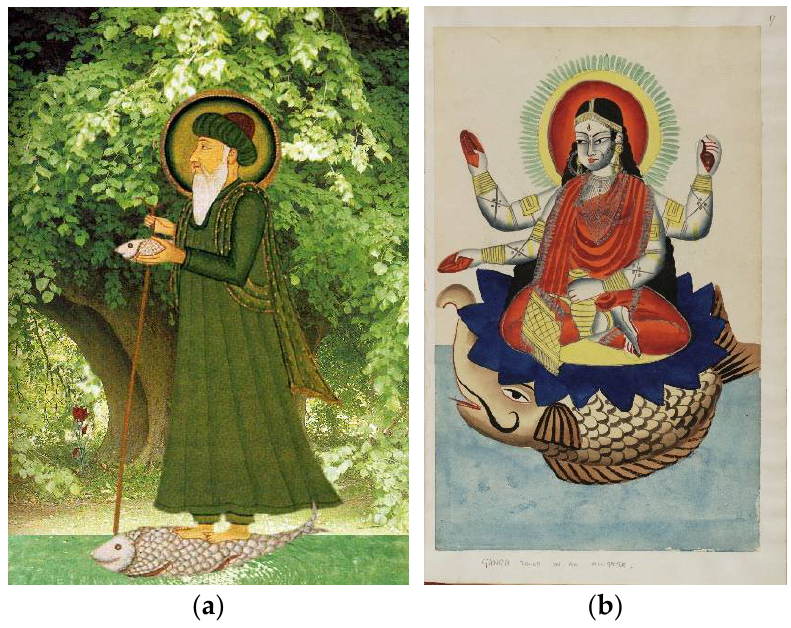
Figure 1. ( a ) Image of Khwaja Khizr, “Khidr”, Source: Wikimedia Commons ,